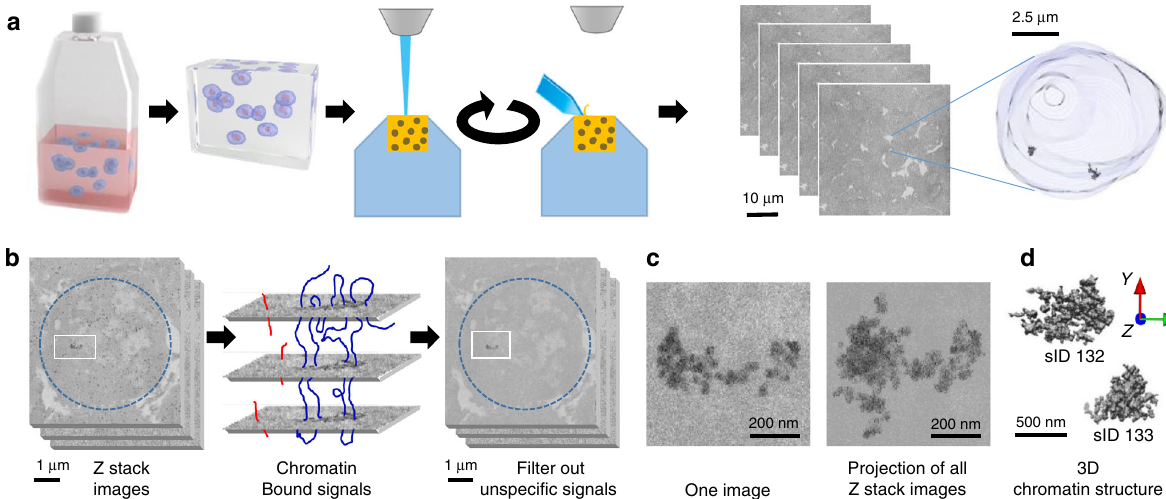
Fig. 1 3D-EMISH method to visualize ultra-resolution 3D chromatin folding. a 3D-EMISH schematic. Cells are grown in suspension. After fi xation with 4% PFA, thrombin – fi brinogen clot is formed. The clot is post fi xed, soaked with cryoprotectant, frozen and cut in 40- µ m sections. Free- fl oating sections are subjected to in situ hybridization with biotinylated DNA probe and processed to SBF-SEM. Then, multiple rounds of ultrathin slicing and imaging are performed. Each cubical sample volume contains dozens of cells. Cell nucleus is segmented, containing two separated target chromatins, as an example in 3D-EMISH. b Image processing for 3D-EMISH. First, we searched for the connected components through z -stack images per each identi fi ed nucleus (blue dotted circle). Second, the chromatin target structures were identi fi ed by removing nonspeci fi c background EM signals. EM signals, connected in multiple consecutive layers were considered as actual target chromatin bound signals, otherwise regarded as chromatin unbound signals, or nonspeci fi c signals. Two scale bars are 1 µ m. c 3D-EMISH image example of one slice and all z -stack projected image after fi ltering out background EM signals. Two scale bars are 200 nm. d 3D reconstructed chromatin-folding structure examples. We assigned unique structure index number (sID) for each structure; scale bar, 500